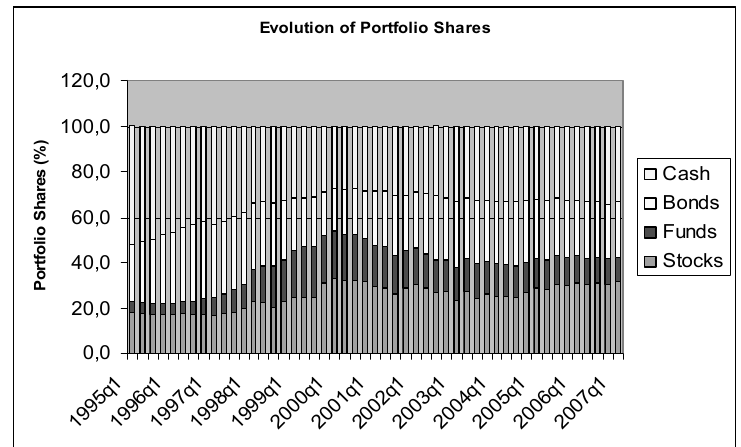
Figure 2 – Evolution of Portfolio Shares; our elaboration based on FA